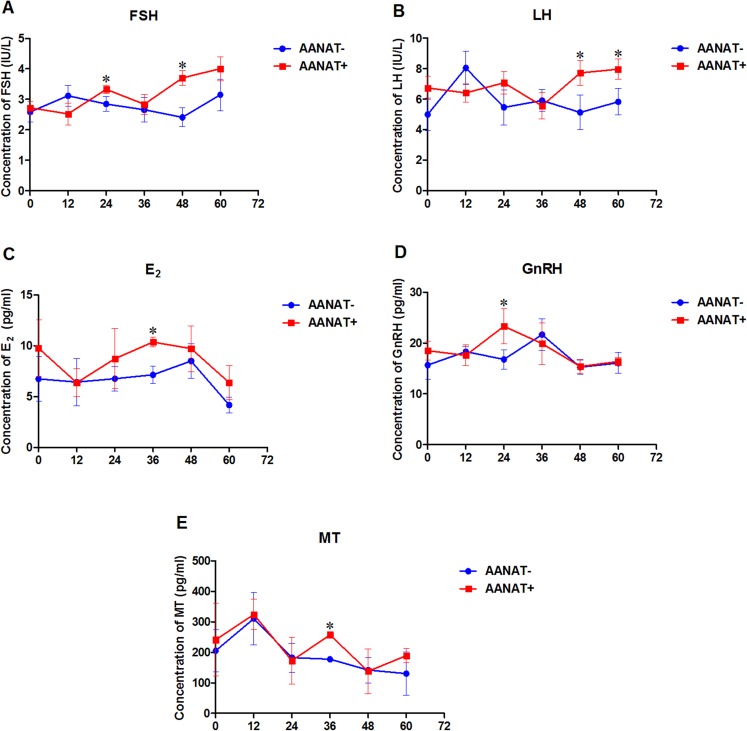
Serum FSH, LH, E2, GnRH, and MT were measured in AANAT+ and AANAT− females.AANAT+: AANAT transgenic-positive females; AANAT−: AANAT-negative females. (A–E) Serum production of FSH, LH, E2, GnRH, and MT collected at 0, 12, 24, 36, 48, and 60 h after vaginal CIDR removal from the control and transgenic-positive females. The times of 12, 36, and 60 h were at night. *Represents significant differences, P < 0.05.